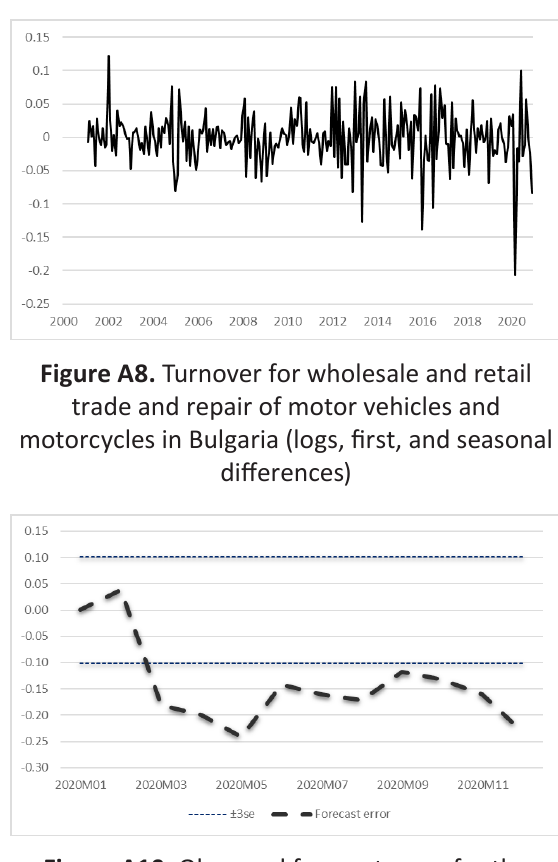
Figure A10. Observed forecast error for the Figure A9. ACF for the turnover for wholesale turnover for wholesale and retail trade and and retail trade and repair of motor vehicles and repair of motor vehicles and motorcycles in motorcycles in Bulgaria (logs, first, and seasonal Bulgaria (logs, first, and seasonal differences) differences)